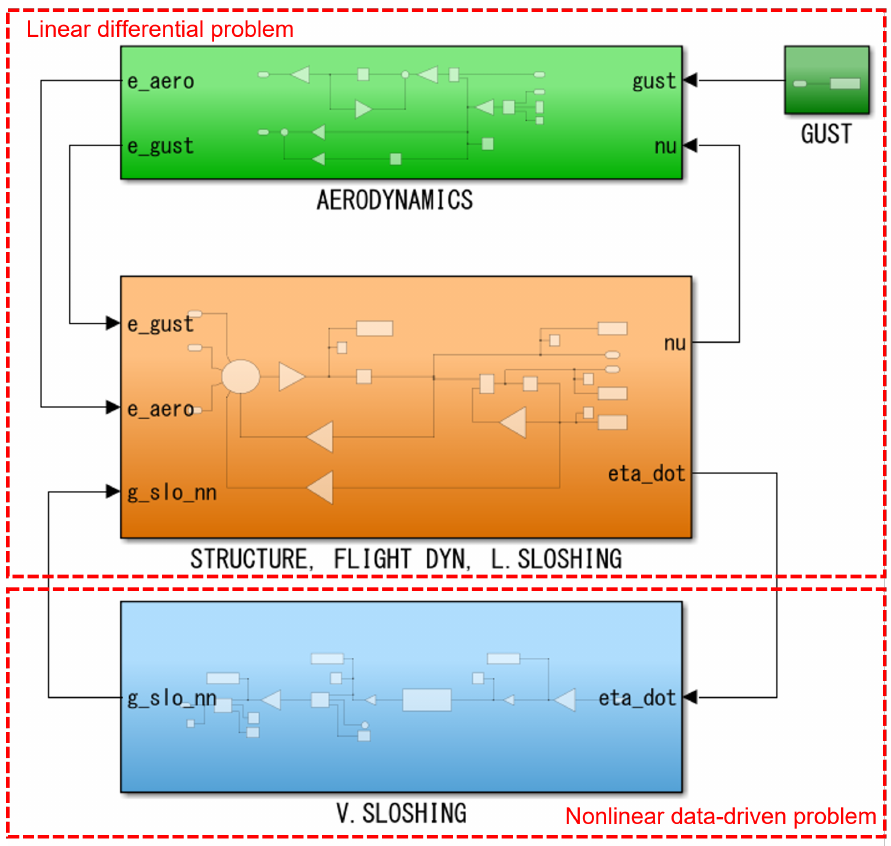
Figure 1. Flexible aircraft with linear and nonlinear sloshing modeling in Simulink ®